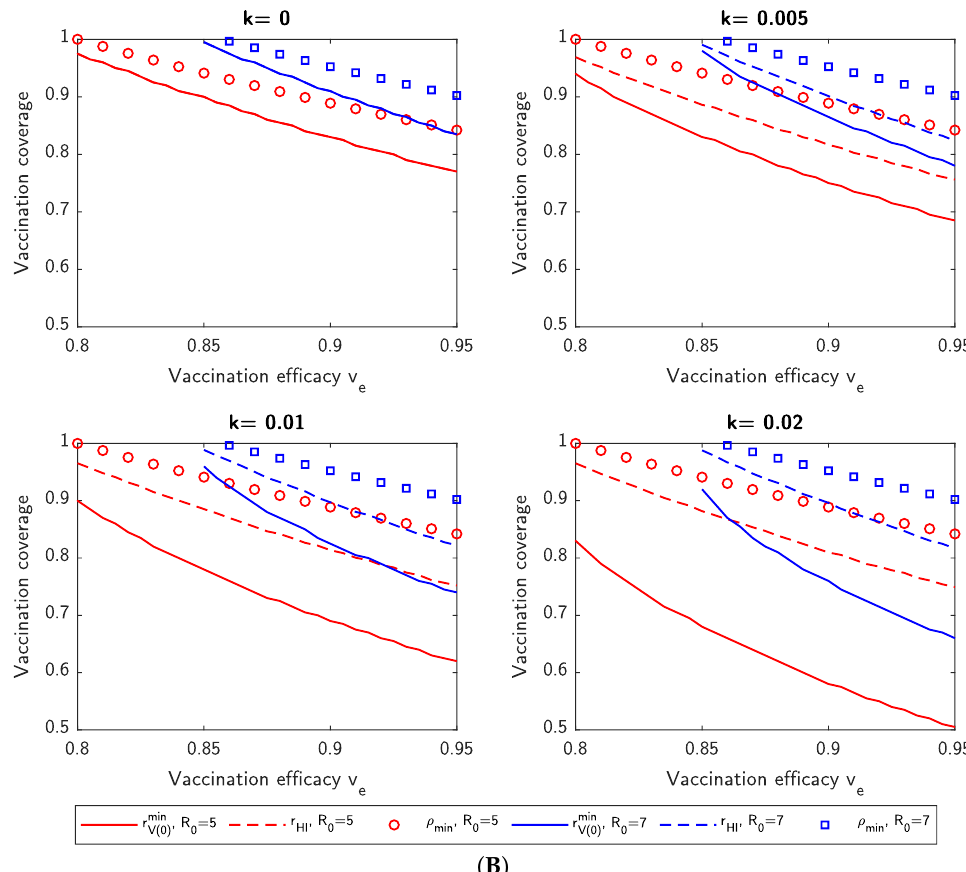
Figure 10. Minimum vaccination threshold required such that the cumulative number of hospi- talizations and isolations is less than ( A ) 0.01 N or ( B ) 0.1 N , for different vaccine efficacies v e and vaccination rates k , and no NPIs ( c = 0). The theoretical herd immunity threshold ρ min is also shown. It is demonstrated that for the 0.01 N case, the proportion of vaccinated individuals when herd immunity is reached (the dynamic vaccination threshold ) is approximately equal to the theoretical herd immunity threshold. On the other hand, for the 0.1 N case, the dynamic vaccination threshold can be much less than the theoretical herd immunity threshold, with post-infection natural immunity becoming a major factor towards achieving herd